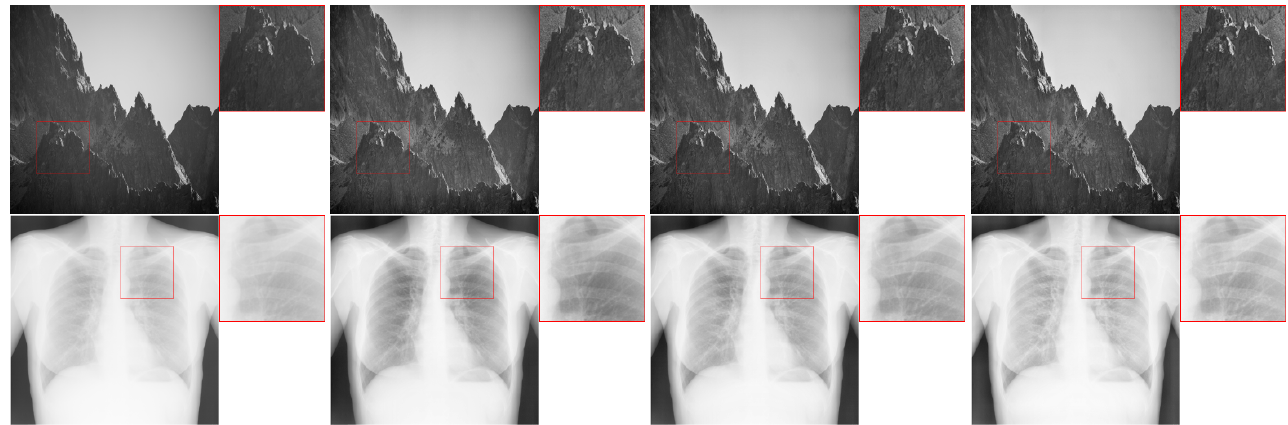
Figure 13. Example results for test images. The figures show successively (from the left) the original image, the result of the CLAHE algorithm for 4 × 4 blocks, the result of the CLAHE algorithm for 8 × 8 blocks, and the result of the CLAHE algorithm for 16 × 16 blocks.